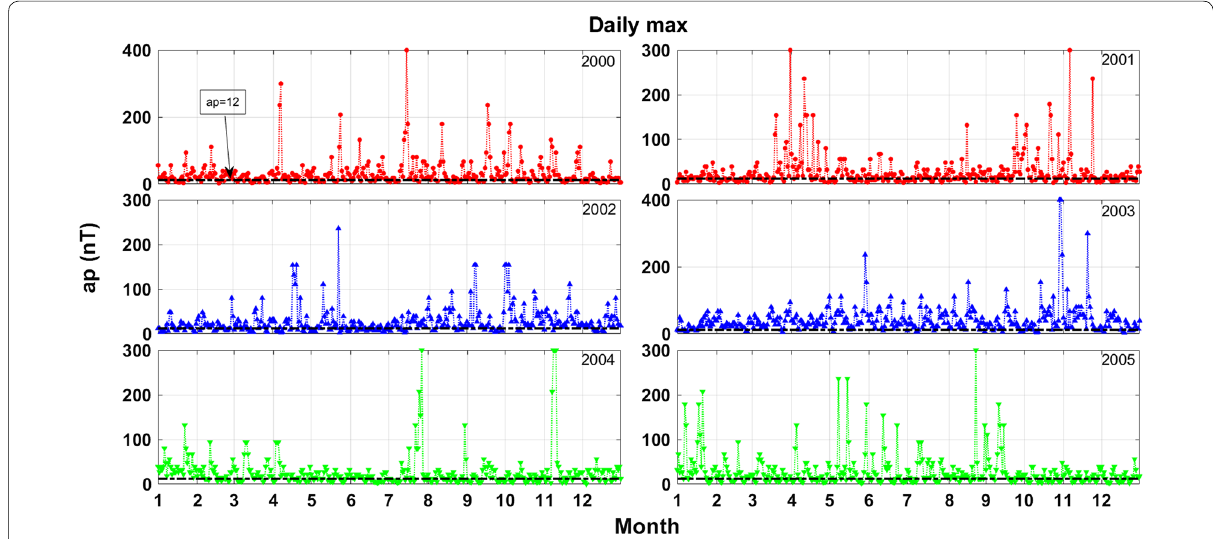
Fig. 2 Daily max ap indices from 2000 to